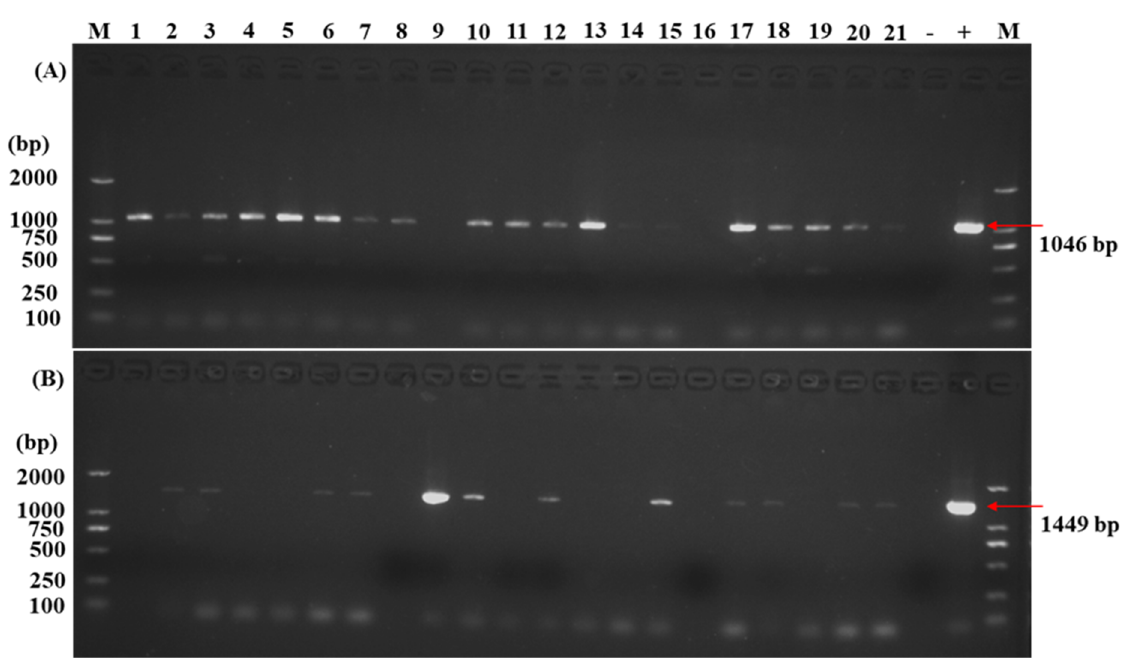
Figure 2. Detection of the transgenes in passion fruit. PCR analysis of genomic DNA of the transgenes using specific primers for ( A ) GUS gene and ( B ) GFP gene. M: DL2000 marker; 1-21: transgenic plants; -: control non-transgenic plants. +: pCAMBIA1301 and pCAMBIA1302 plasmid DNA as positive control. Table 2. Rate of regeneration, transformation, single or multiple buds of Passiflora edulis after in planta transformation and regeneration. Data are represented as mean ± SD (standard deviation)